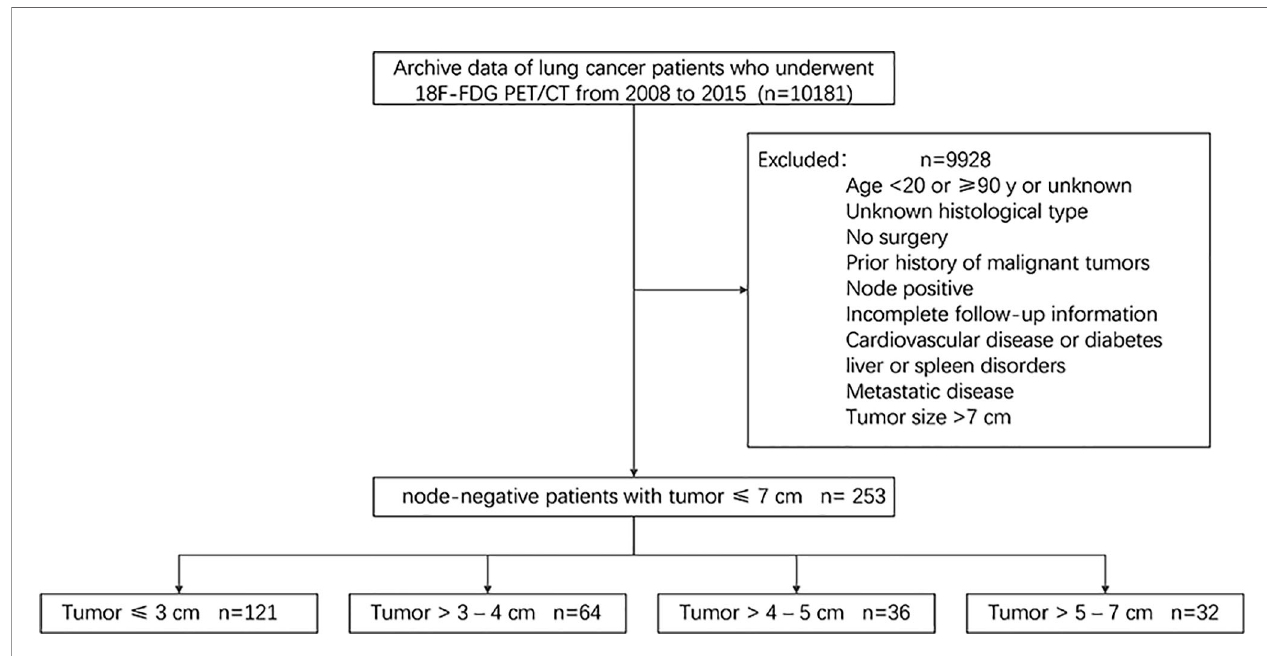
FIGURE 1 | Flow diagram shows the details of patient